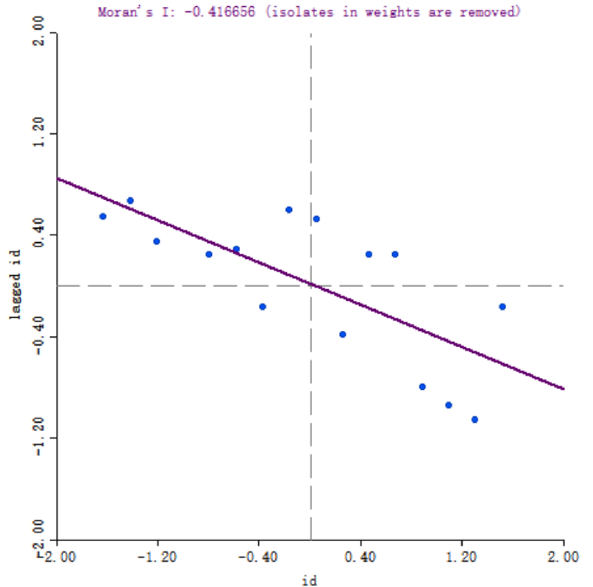
Figure 5. The Moran’s I scatterplot of 16 port efficiency in 2020.